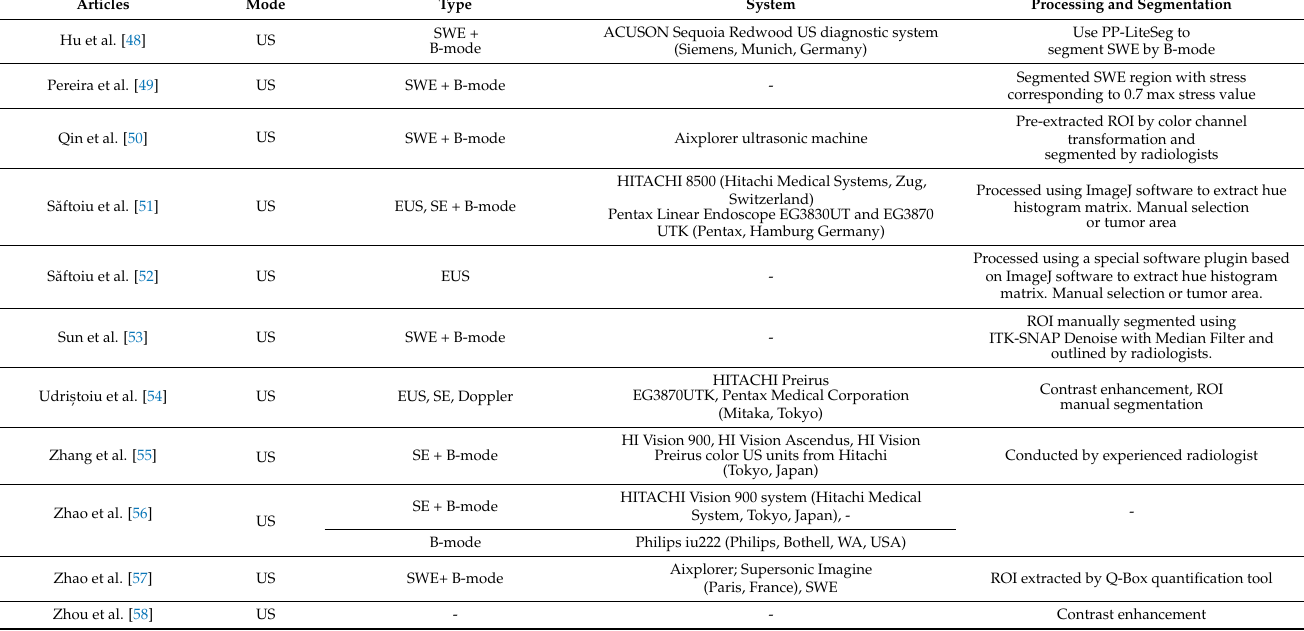
Table 2. Configuration of elastography system and image segmentation.